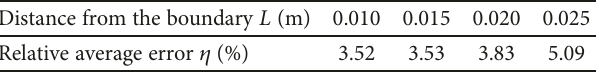
Figure 8: Impacts of di ff erent measuring point positions on inversion results when σ = 0 00 and R = 2 . Table 2: Relative average error of inversion results of di ff erent measuring point positions when σ = 0 00 and R = 2 .